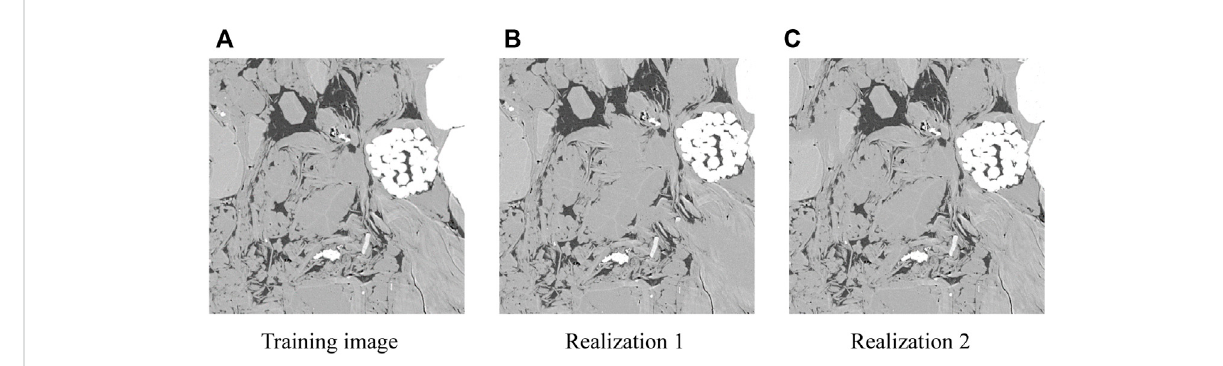
FIGURE 10 Comparison of 2D shale gray digital rocks (A) Training image, (B) realization 1and (C) realization 2. Realizations are reconstructed based on the training image using the proposed